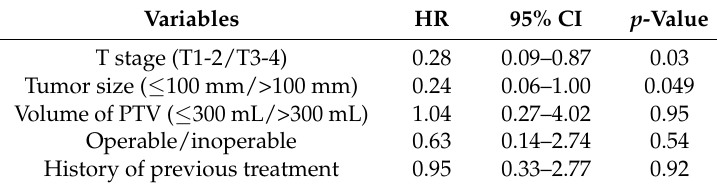
Table 2. Multivariate analysis of potential predictive factors for progression-free survival (PFS).